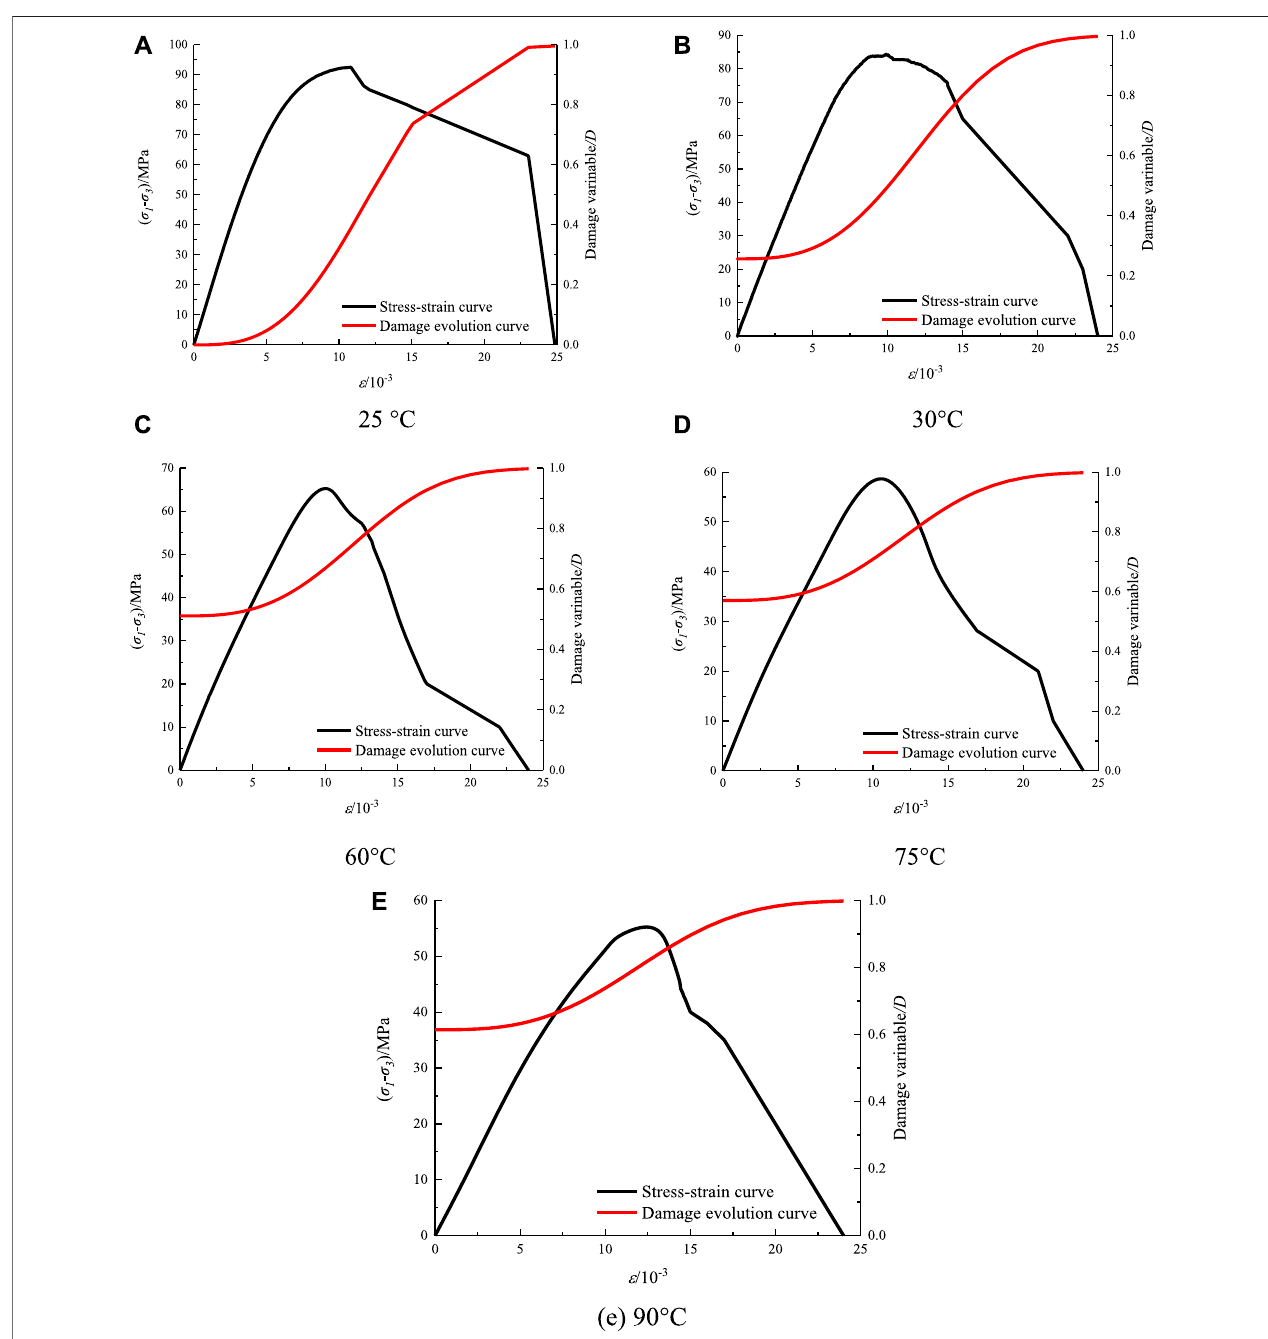
FIGURE 12 | Sandstone damage at different temperatures under 45 MPa con fi ning pressure.